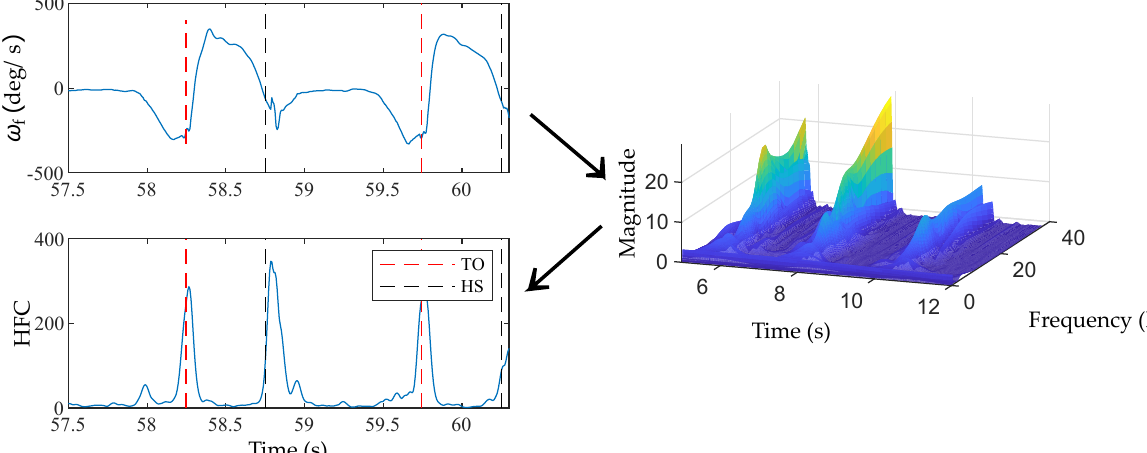
Figure A2. An implementation of wavelet transform for gait event detection. Sagittal plane angular velocity ( ω f ) of the foot (top left plot), which is in time domain, was first transformed into time-frequency domain using wavelet transform (right plot). Then, the high-frequency region was condensed into time domain (bottom left plot) by evaluating the cross section area of the magnitude of wavelet transform. A real-time implementation of the method was limited by computational complexity. HFC—high frequency